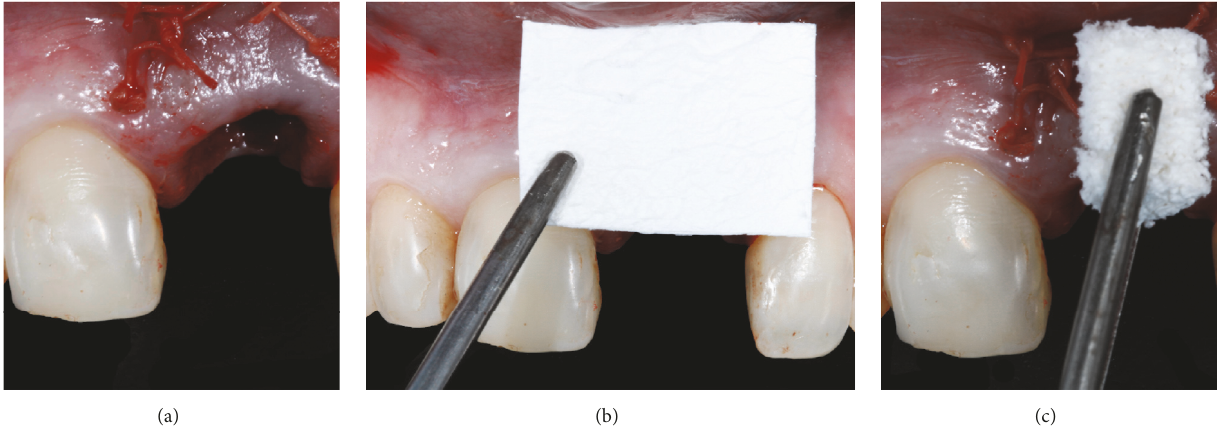
Figure 4: A thick connective tissue graft was sutured internally in the socket buccal tissue (a). A non-cross-linked membrane was trimmed and placed in contact with the soft tissue graft and the most apical portion of the socket (b). The socket was reconstructed with inorganic bovine bone graft containing 10% porcine collagen (c).